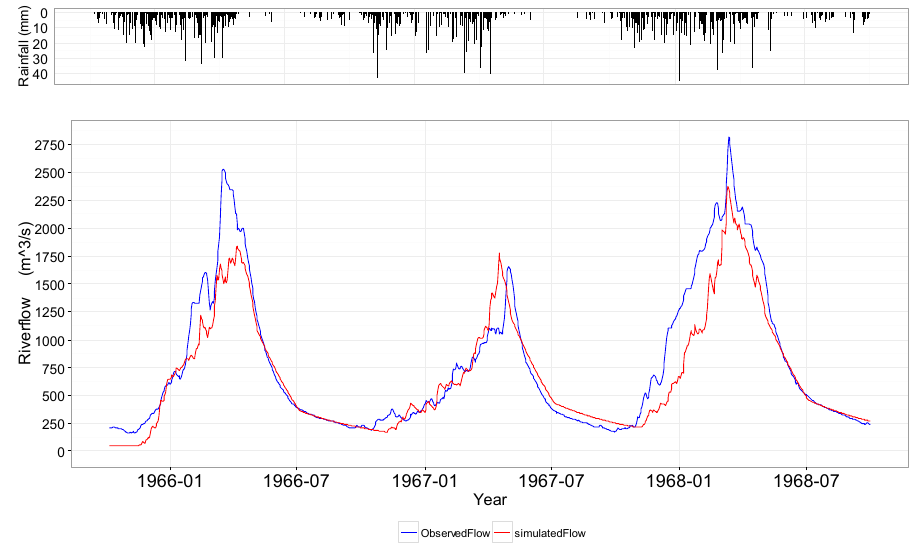
Figure 5. HBV hydrological model calibration for Kwanza River Basin, Angola.